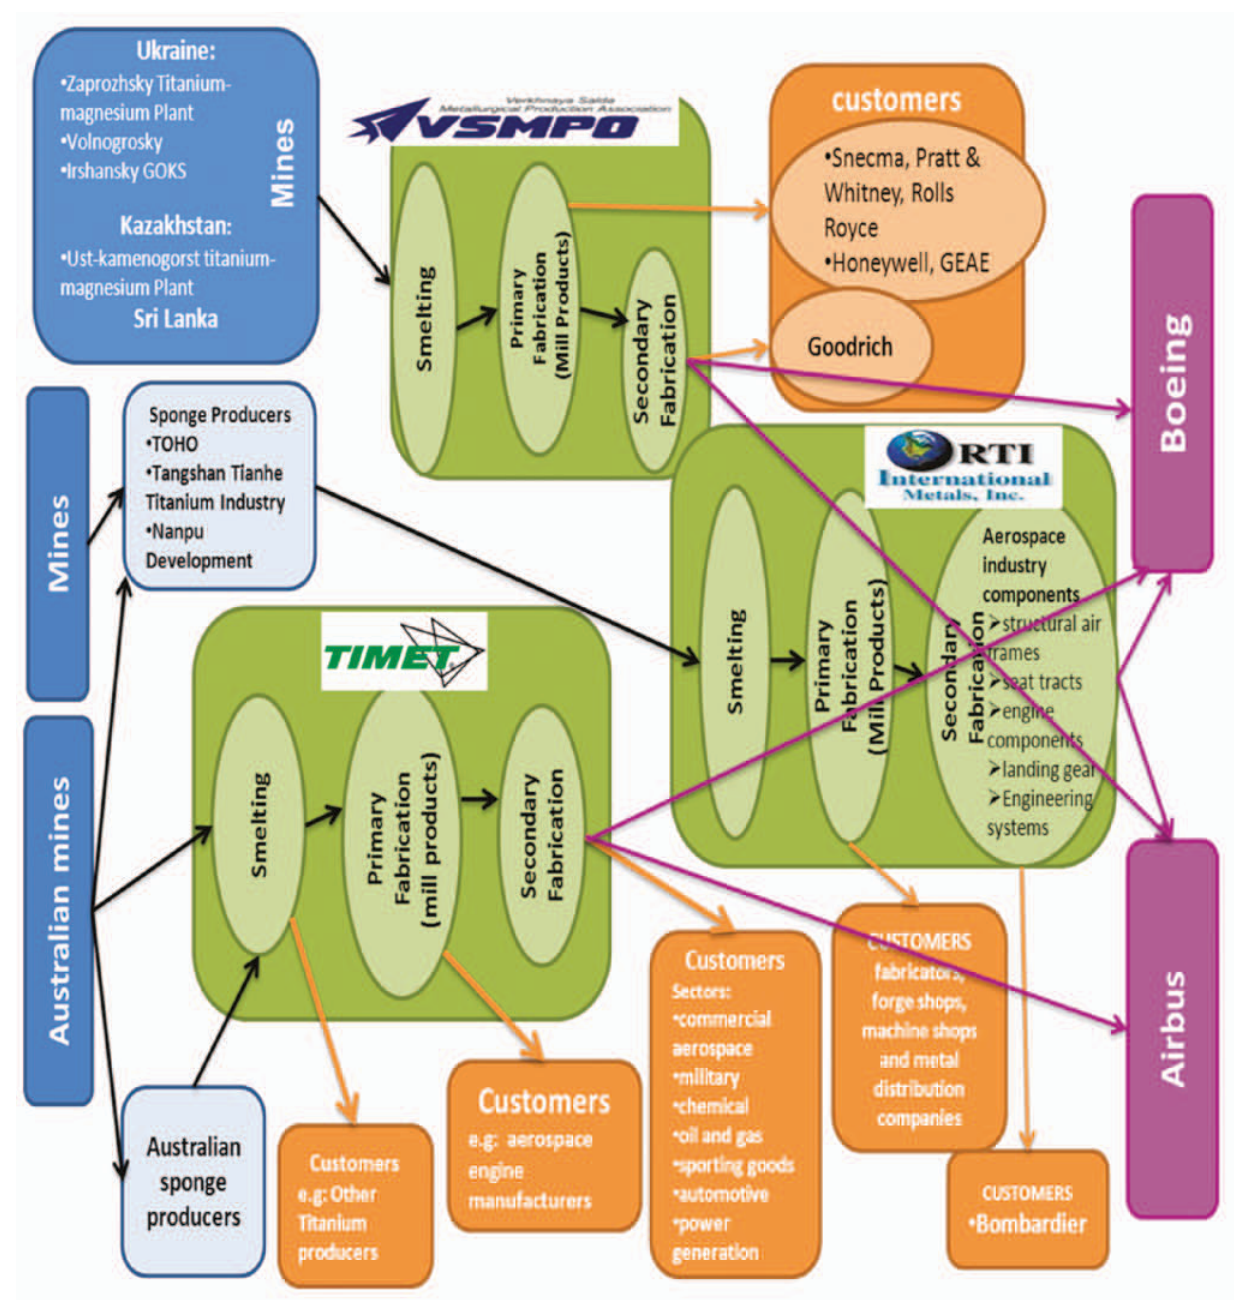
Figure 5: Integrated supply chain showing the increase in complexity of the global market versus the previous localised supply